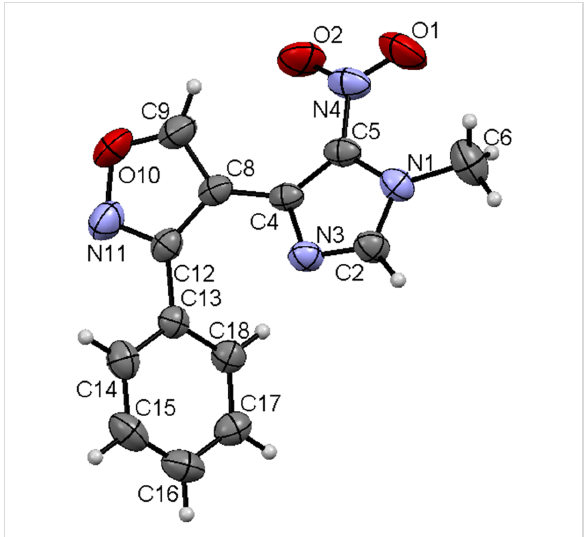
Figure 3: Imidazolylisoxazole 4a according to XRD data in the ther- mal ellipsoids of the 50% probability level.